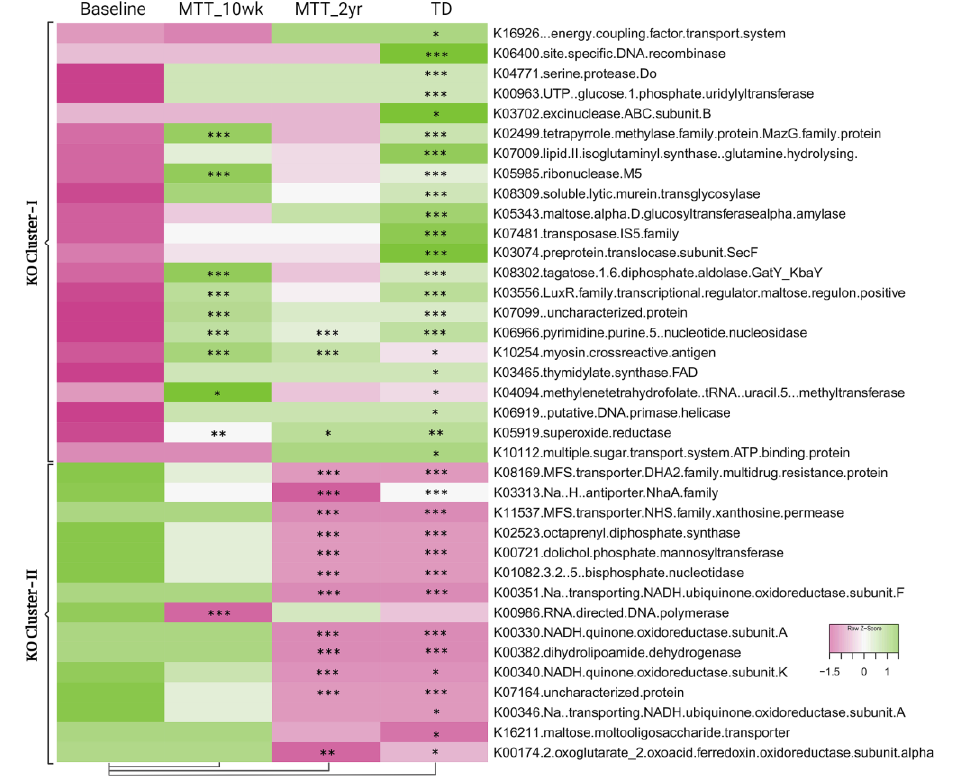
Figure 5. Heatmap of KOs that were significantly lower (KO Cluster-I) or higher (KO Cluster-II) in ASD baseline vs. TD. The heatmap also shows how KOs changed after MTT compared to Baseline, and generally became more similar to the TD group. The median of bacterial relative abundance was used to construct the heatmap for each group. * Single asterisk indicates p < 0.05, ** double asterisks indicate p < 0.01, triple *** asterisks indicate p < 0.001. Univariate statistical comparisons were made for ASD Baseline vs. all other groups. All p -values are FDR-corrected. ASD: autism spectrum disorder; TD: typically developing.